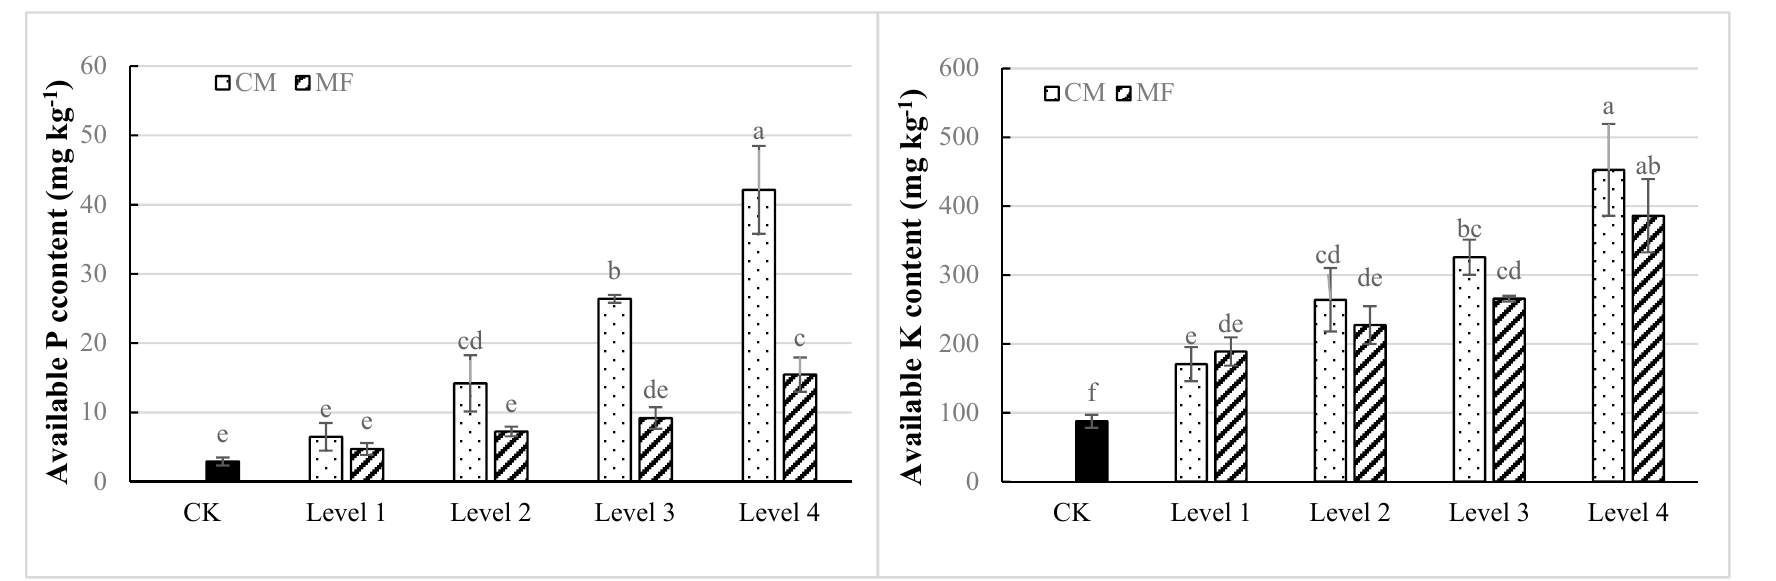
Figure 5. Soil available P and K of 0–30 cm soil layer under two types of fertilizer at four application levels CK: Control treatment (non-fertilized); CM: cattle manure; MF: mineral fertilizer; Level 1 corresponding to 3 t CM ha − 1 , Level 2 to 6 t CM ha − 1 , Level 3 to 9 t CM ha − 1 , Level 4 to 12 t CM ha − 1 . Error bars are standard error of three replicates. Different lowercase letters indicate statistical differences (p ≤ 0.05) among fertilizer treatments